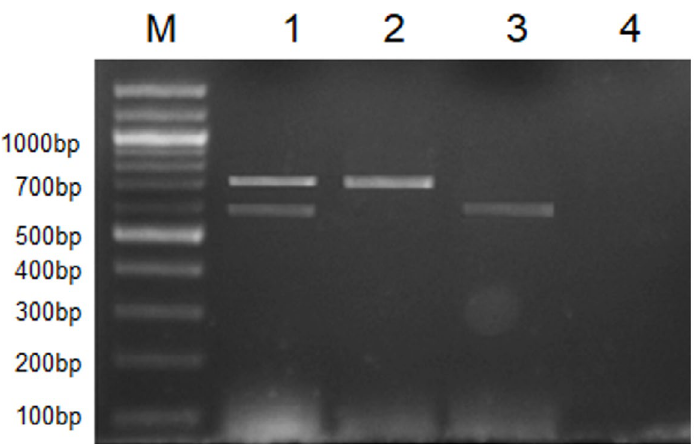
Fig. 1. Multiplex PCR for pathogenic and saprophytic Leptospira. M: 100 bp marker, 1: Lipl32 and Lipl21 , 2: Lipl32 from L. interrogans ser. Icterohaemorrhagiae, 3: Lipl21 from L. meyeri ser . Semaranga, 4: Negative control.